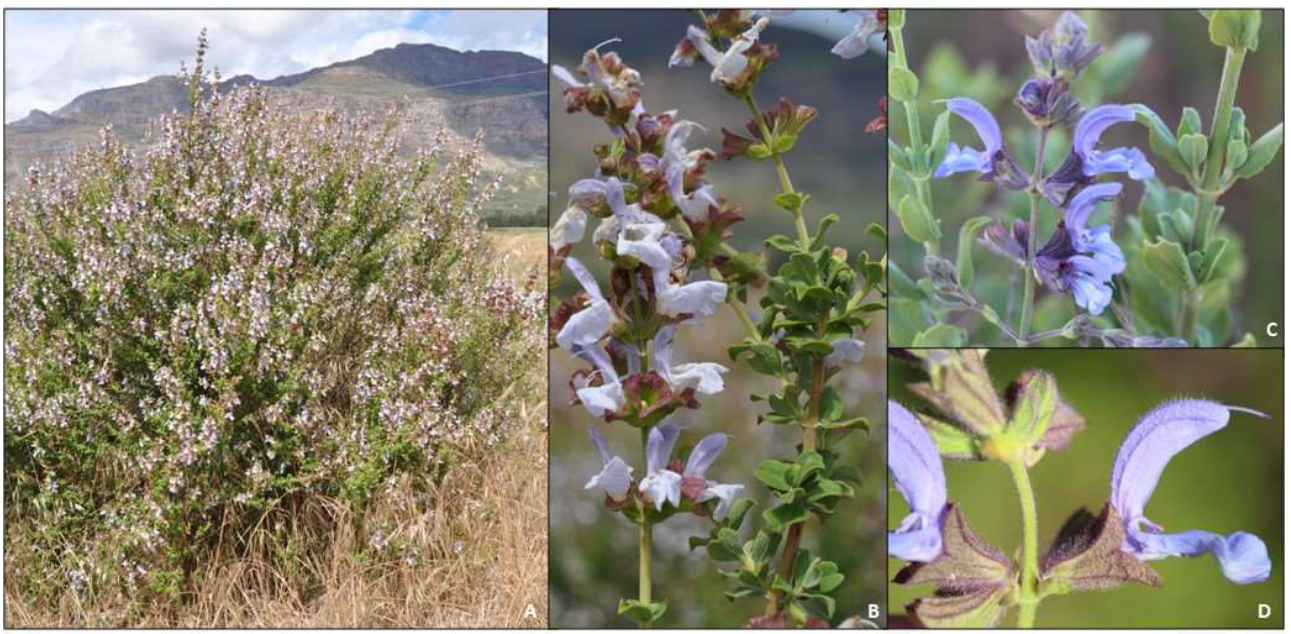
Figure 4. Morphology and diagnostic characters of Salvia africana . ( A ) habit (Cederberg); ( B ) inflo- rescence and leaves (Malmesbury); ( C ) flowers (Cederberg; note hirsute calyx). All photographs taken by B.-E. Van Wyk.